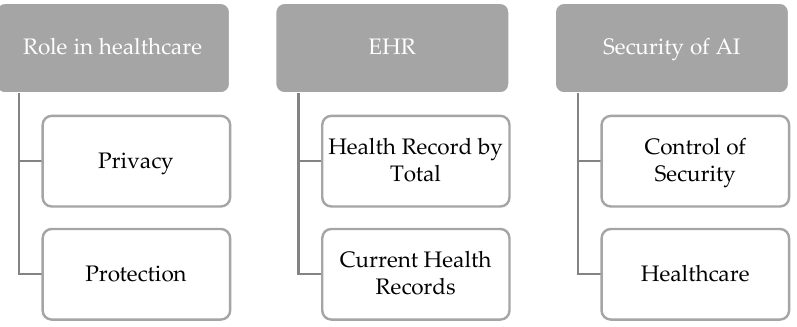
Figure 11. Healthcare applications of AI and blockchains.